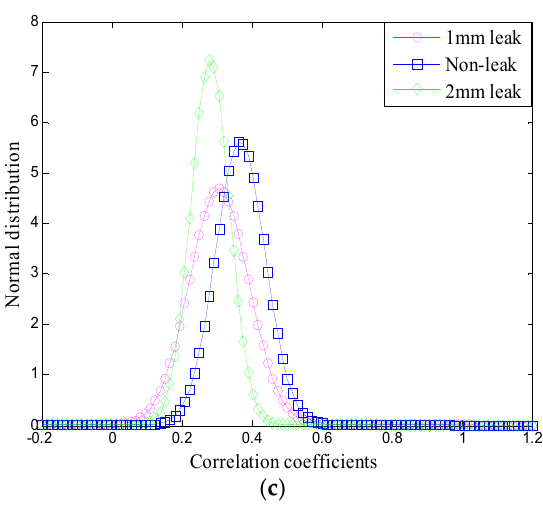
Figure 10. Normal distribution curves based on EMD: ( a ) for 1# case; ( b ) for 2# case; and ( c ) for 3# case.